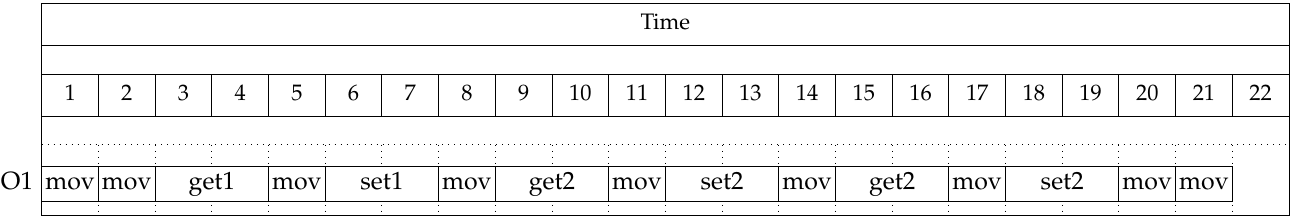
Figure 12. Schedule of actions for a scenario based on a walk of the length of 15 arcs.